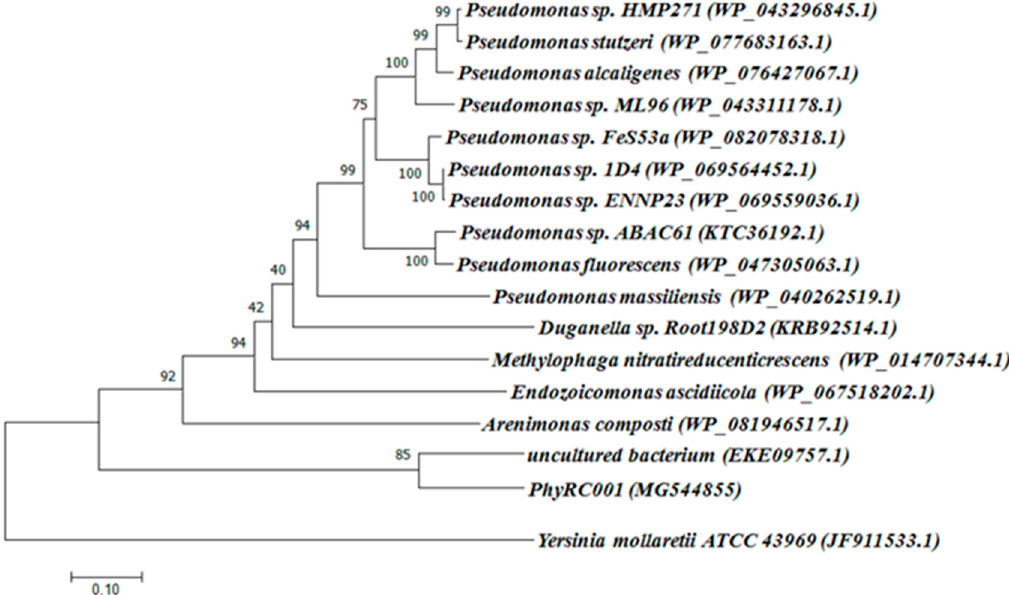
Figure 2. Classification of PhyRC001 based on amino acid sequence analyses. Amino acid sequences of phytases, including PhyRC001, were compared and analyzed phylogenetically using a neighbor-joining method. GenBank accession numbers are in parentheses. Phylogenetic analysis showed that PhyRC001 is closely related to phytases from an uncultured species. The histidine acid phosphatases (HAPs) phytase of Yersinia mollaretii ATCC 43969 (JF911533.1) was included as an outgroup.